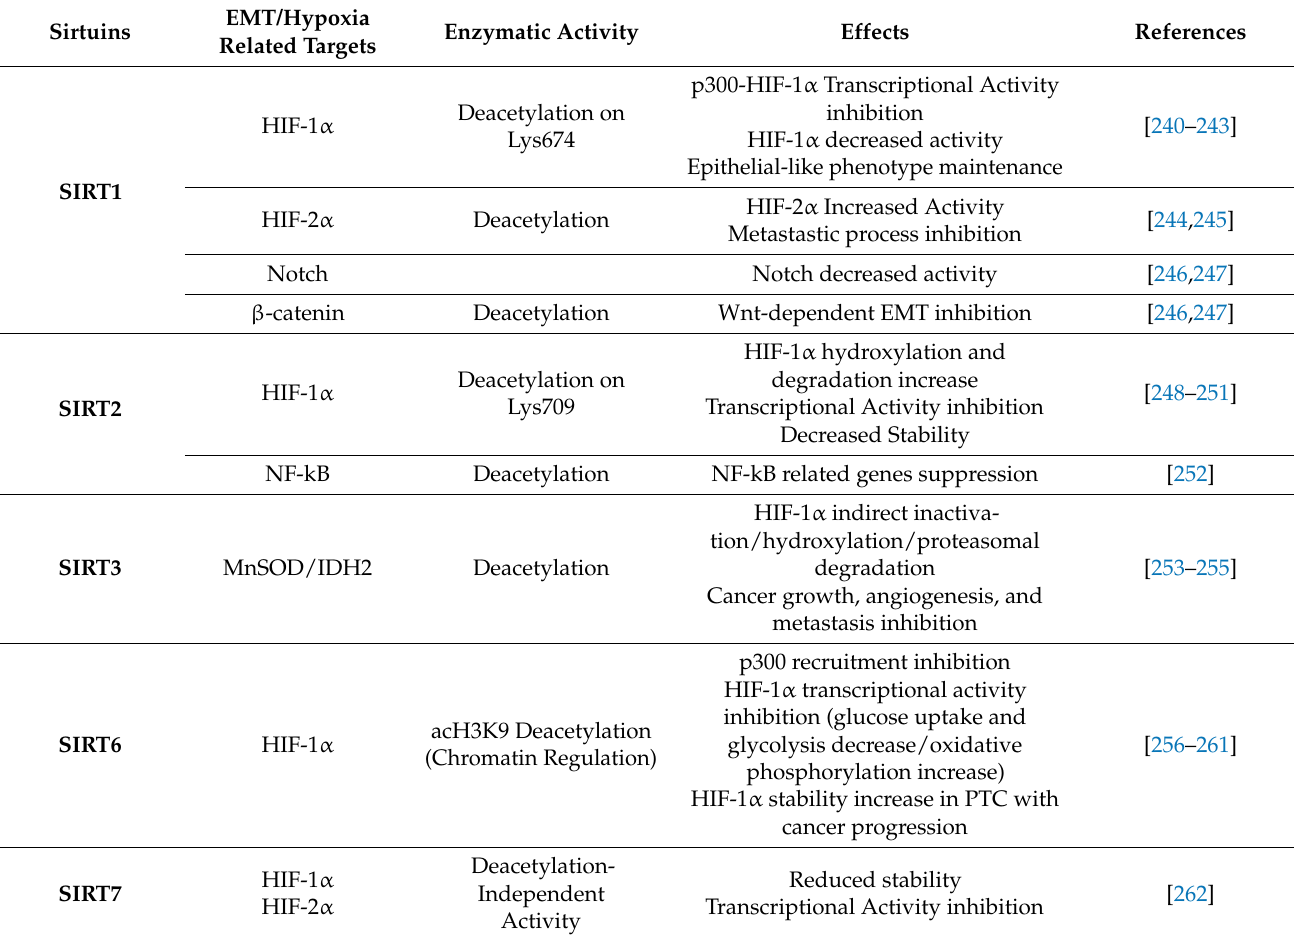
Table 1. Connections between sirtuins and hypoxia-inducible-factors HIF-1 α and HIF-2 α . The deacetylation sites on HIF-1a are reported for SIRT1 and SIRT2. Moreover, the effects on protein stability and transcriptional activity are